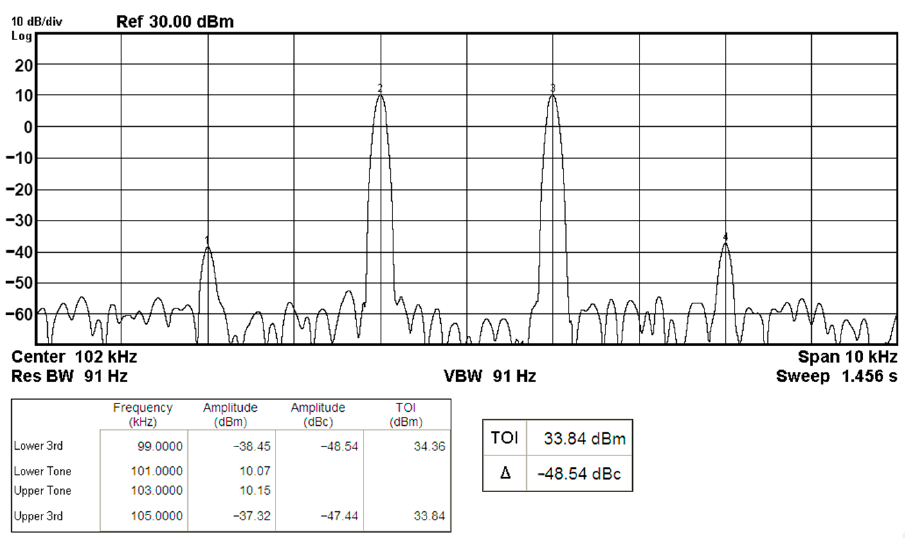
Figure 17. The measured BPF output spectrum for a two-tone intermodulation distortion test.